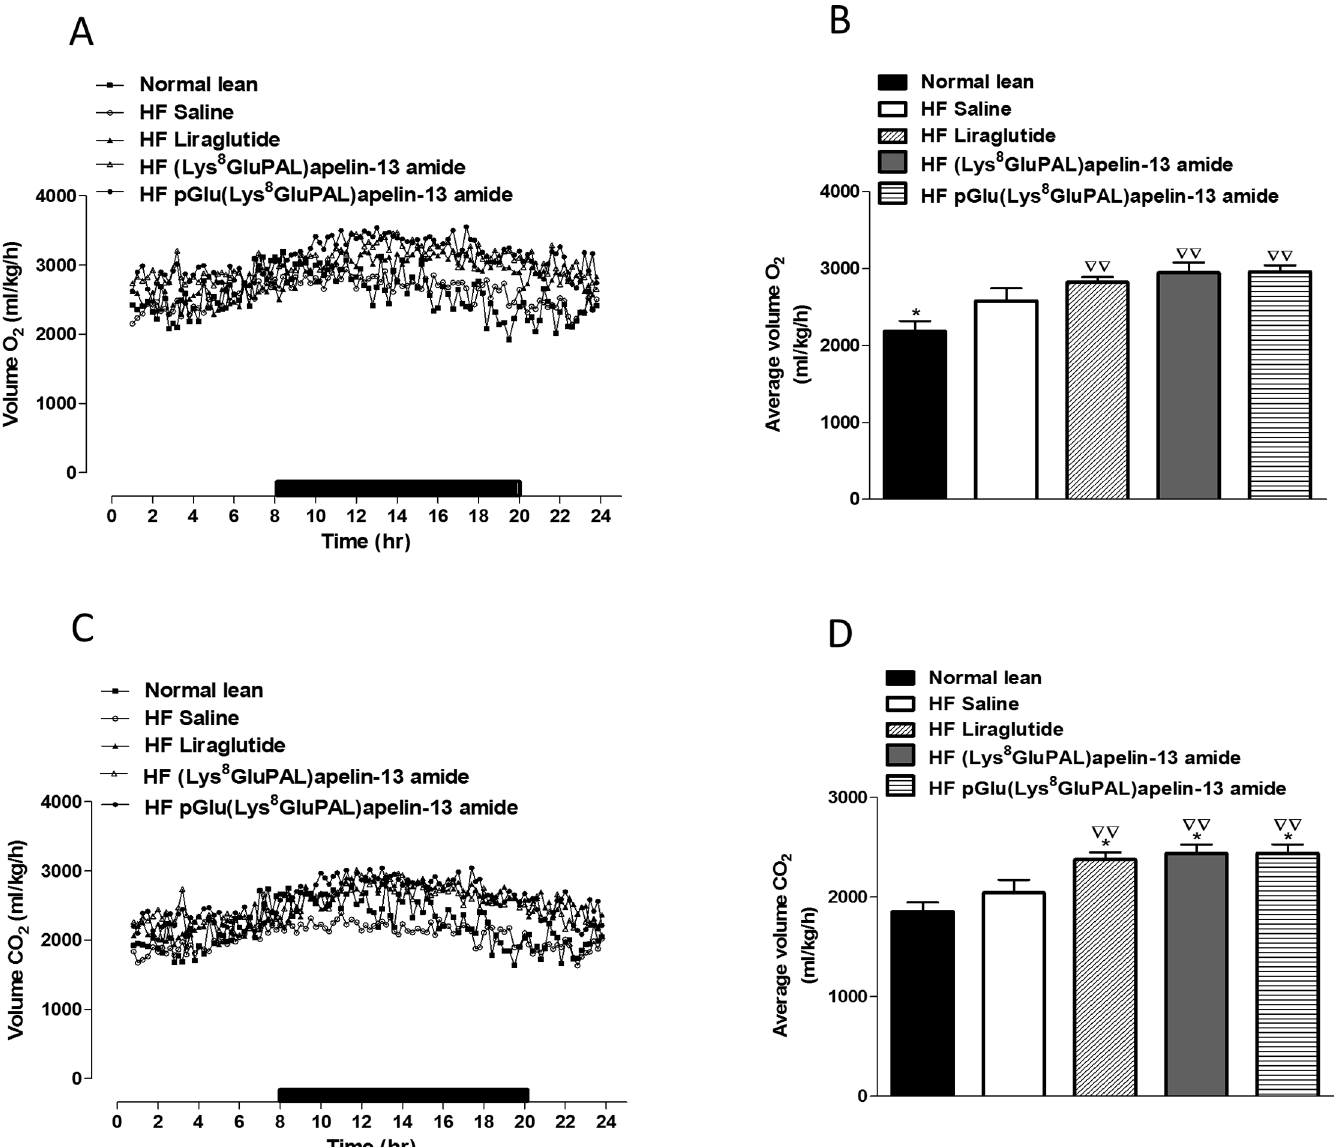
Fig 6. Effect of once daily i.p. administration of liraglutide, (Lys 8 GluPAL)apelin-13 amide or pGlu(Lys 8 GluPAL)apelin-13 amide (each at 25 nmol/kg bw) on O 2 consumption (A, B) and CO 2 production (C, D). Following 36-days of treatment mice were placed in CLAMS metabolic chambers for 24 h to acclimatise and a further 24 h for measurements (12 h dark period as shown by the black bar), O 2 consumption and CO 2 production were measured for 30 sec at 25 min intervals. Values represent the mean ± S.E.M. (n = 6) where (cid:3) p < 0.01 is compared to high-fat fed saline treated mice and 55 p < 0.01 is compared to normal mice.